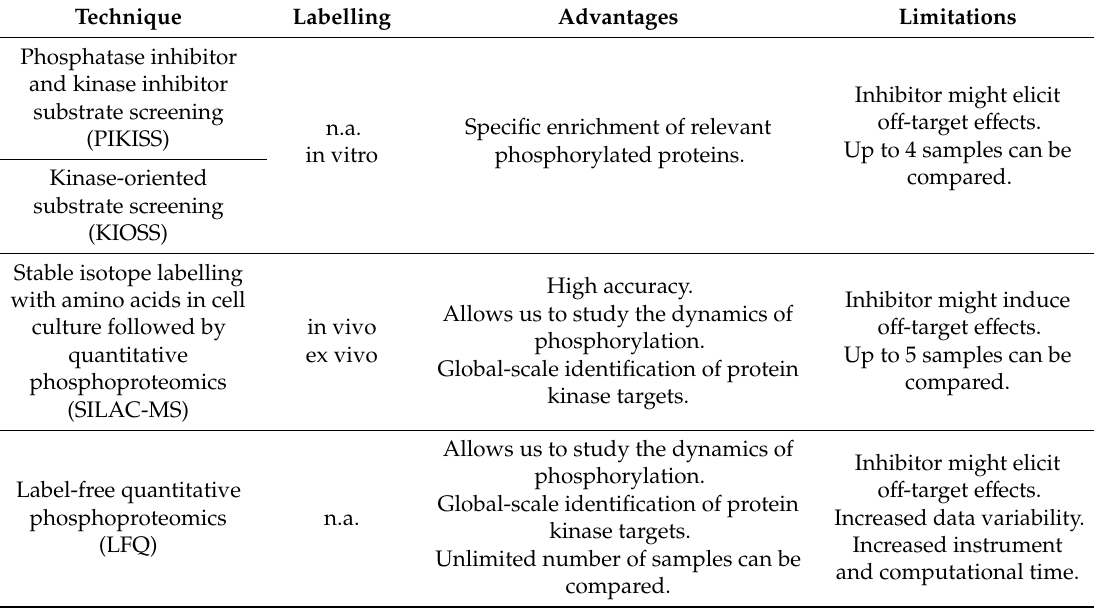
Table 2. Summary of the basic characteristics of selected indirect phosphoproteomics-based techniques developed to identify protein kinase targets and characterize the dynamics of protein